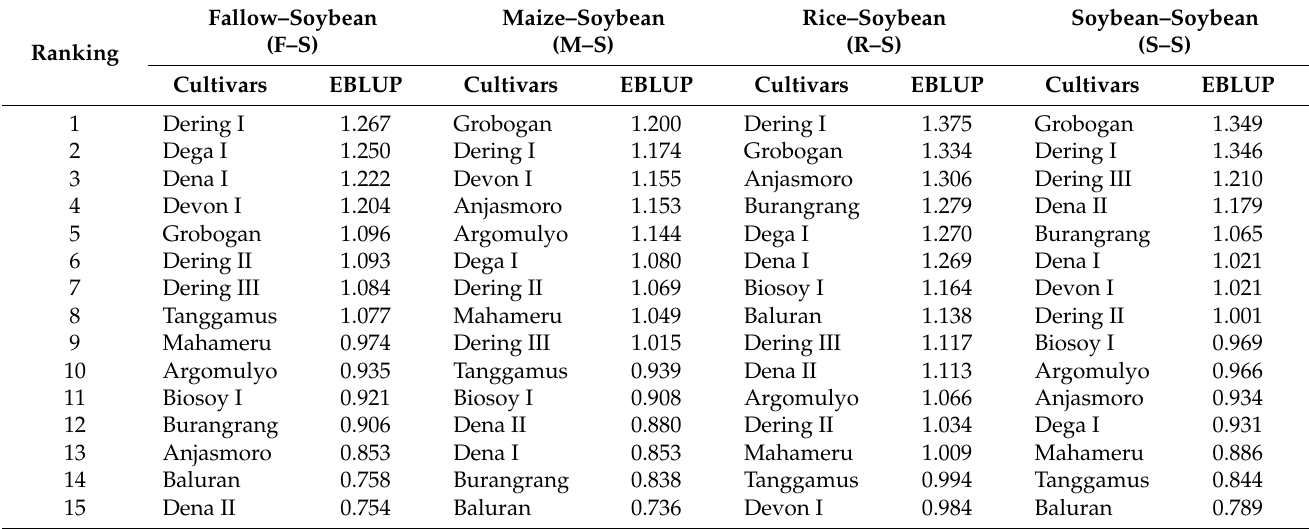
Table 6. Ranking and empirical best linear unbiased prediction (tons ha − 1 ) of 15 soybean cultivars in each crop rotation model during the wet season.